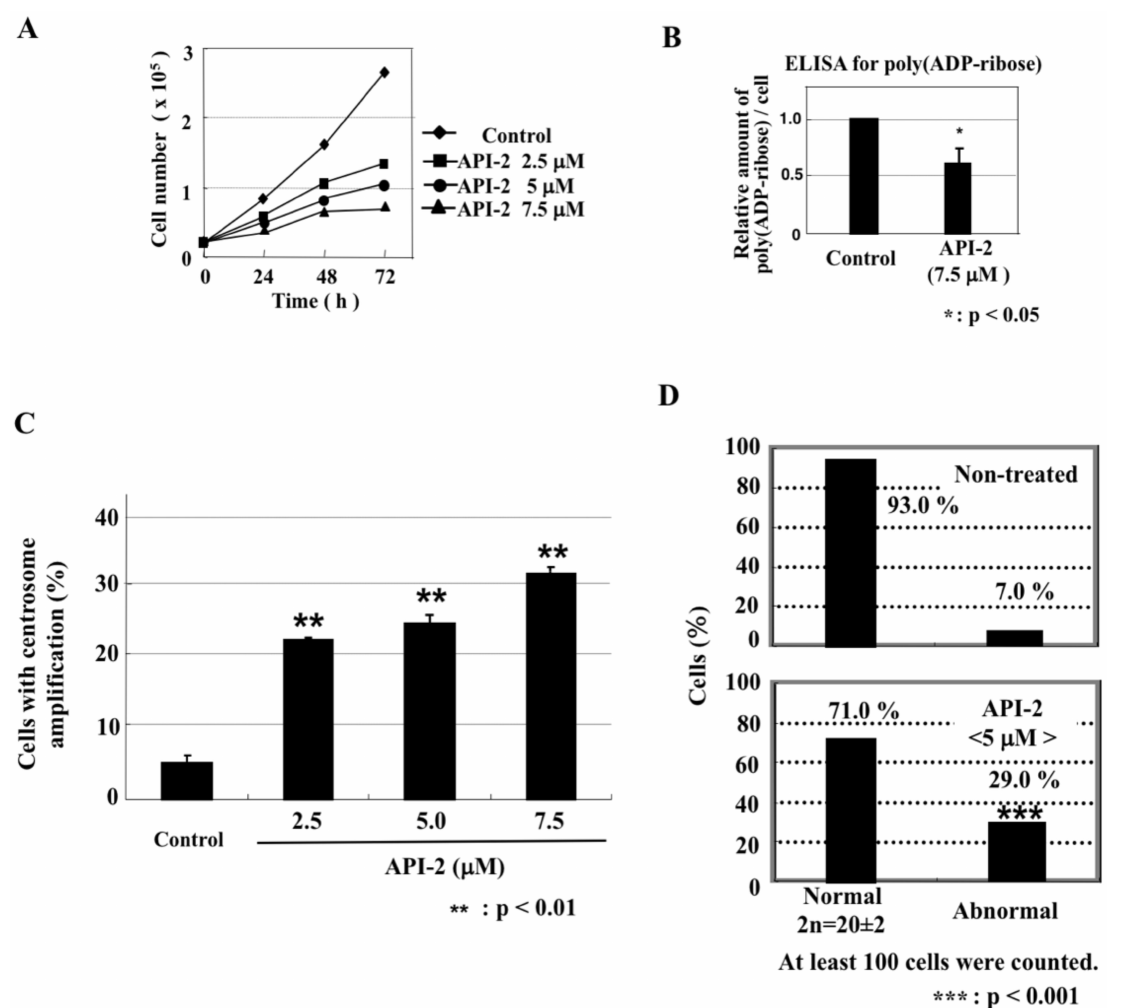
Figure 6. Another Akt inhibitor, API-2, also induced centrosome amplification and aneuploidy of chromosomes. ( A ) Inhibition of cell proliferation with indicated concentrations of API-2. ( B ) Relative in vivo level of poly(ADP-ribose) per cell, determined by ELISA, after culturing cells with API-2 for 48 h. ( C ) Percentage of cells with centrosome amplification. Significance was assessed against the control. ** p < 0.01. ( D ) Cells with the number of chromosomes outside of the range of 20 ± 2 were defined as abnormal. Significance was analyzed with Fisher’s exact test against the control. *** p <